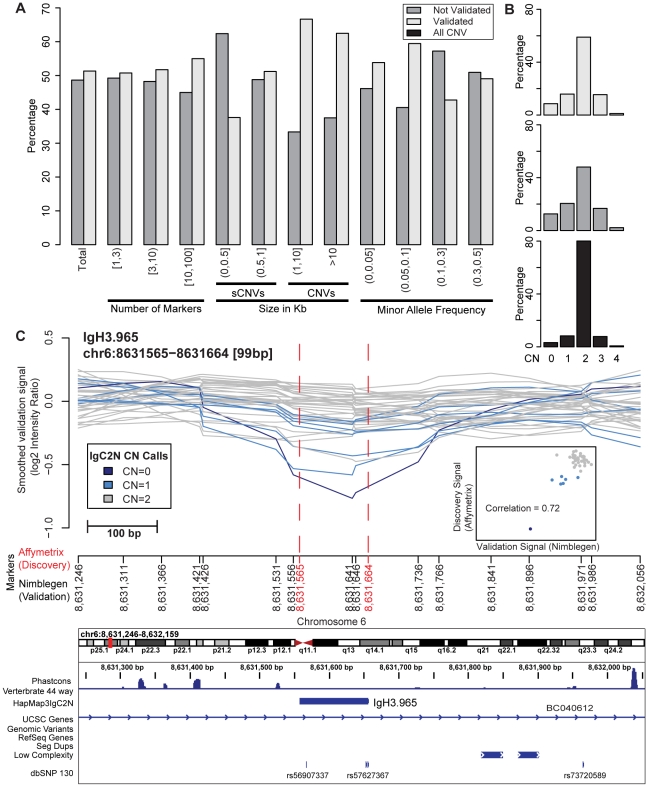
Validation study summary.(A) Barplots of the rate (percentage) of validation categorized with respect to number of marker coverage, size of the variant and its minor allele frequency. (B) The frequency distribution of CN genotypes of validated, not validated and all CNV. (C) An example of a new variant validated by NimbleGen data: The line plots of smoothed intensity signal using 42M NimbleGen platform for each of 40 HapMap samples showing polymorphism for the locus IgH3.965 on Chromosome 6. A scatter plot (inset) of the discovery signal (x-axis) and the validation signal (y-axis) color coded with respect to the IgC2N CN call on the discovery samples.